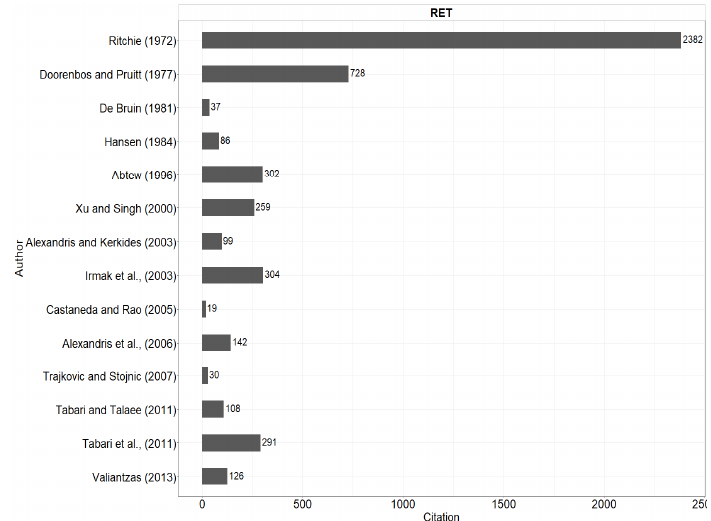
Figure 5. Citations of RET radiation-based equations.